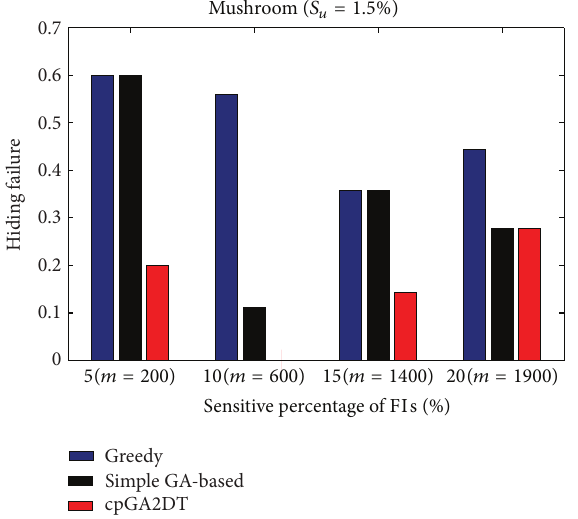
Figure 15: Comparisons of hiding failure at various sensitivity percentages of the frequent itemsets for BMSWebview-2 database.